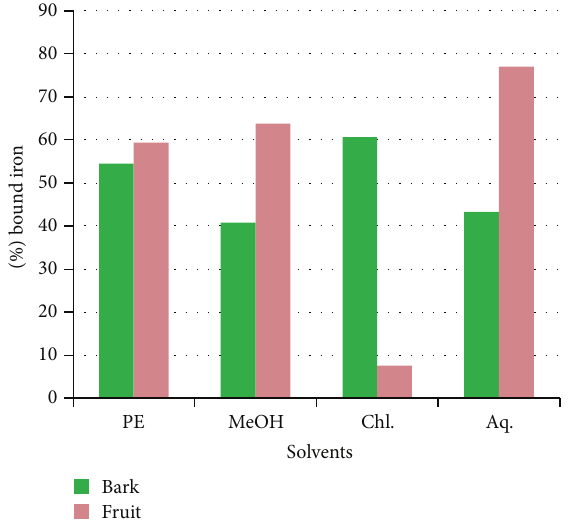
Figure 18: Metal chelating activity of different parts of C. ambro- sioides .